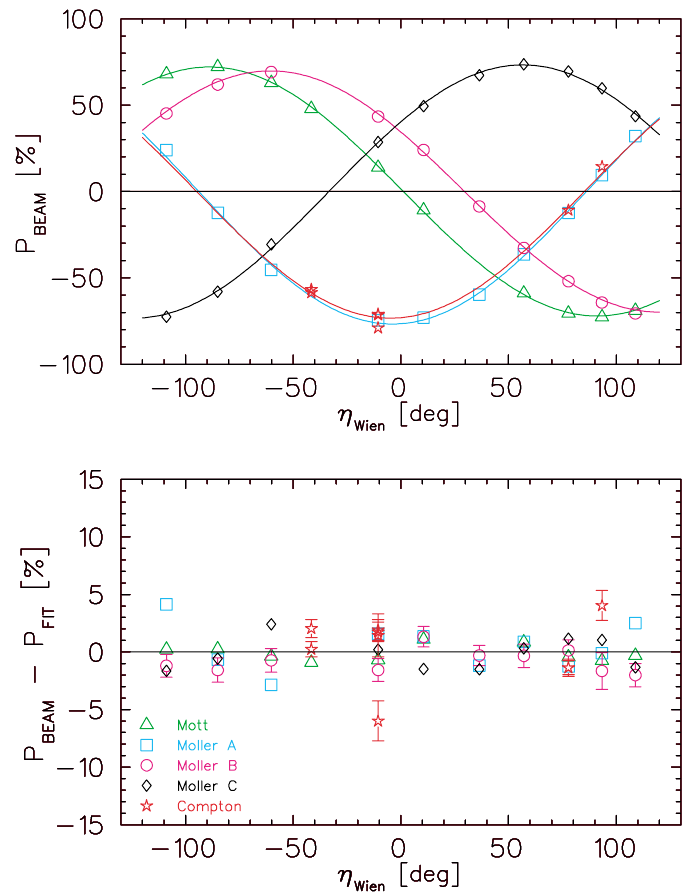
FIG. 8. (Color) Measured polarizations and fits (upper plot) using (cid:12) and all data. Fit residuals (lower plot), with only statistical uncertainties from the fits shown. In general, the uncertainties from the fits are smaller than the symbol sizes used in plotting the data. Note: the lower plot legend applies to the upper plot.